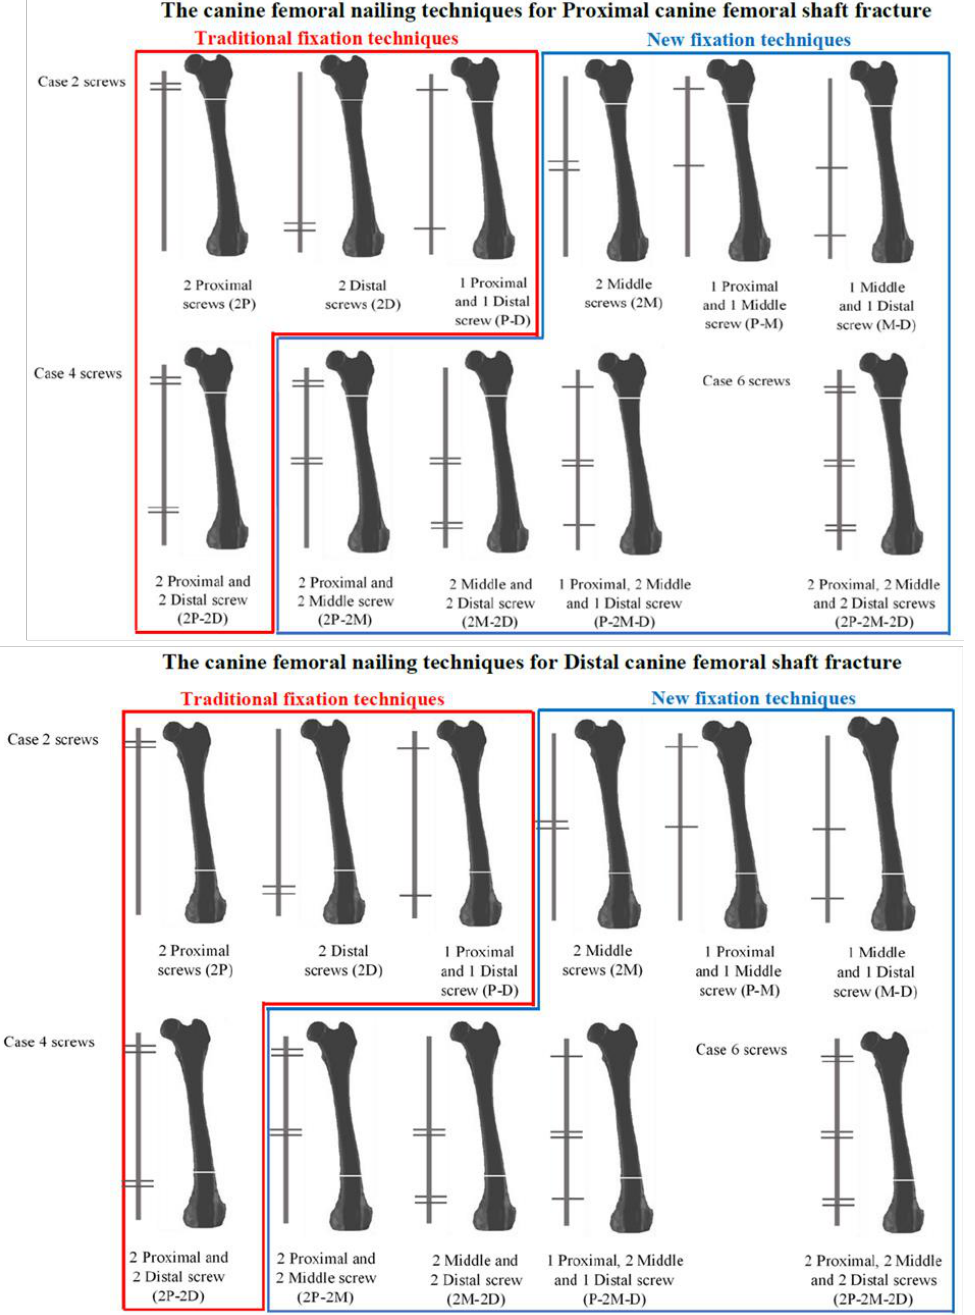
Figure 2. The finite element analysis (FEA) models with proximal and distal canine femoral shaft fractures and fixation techniques.